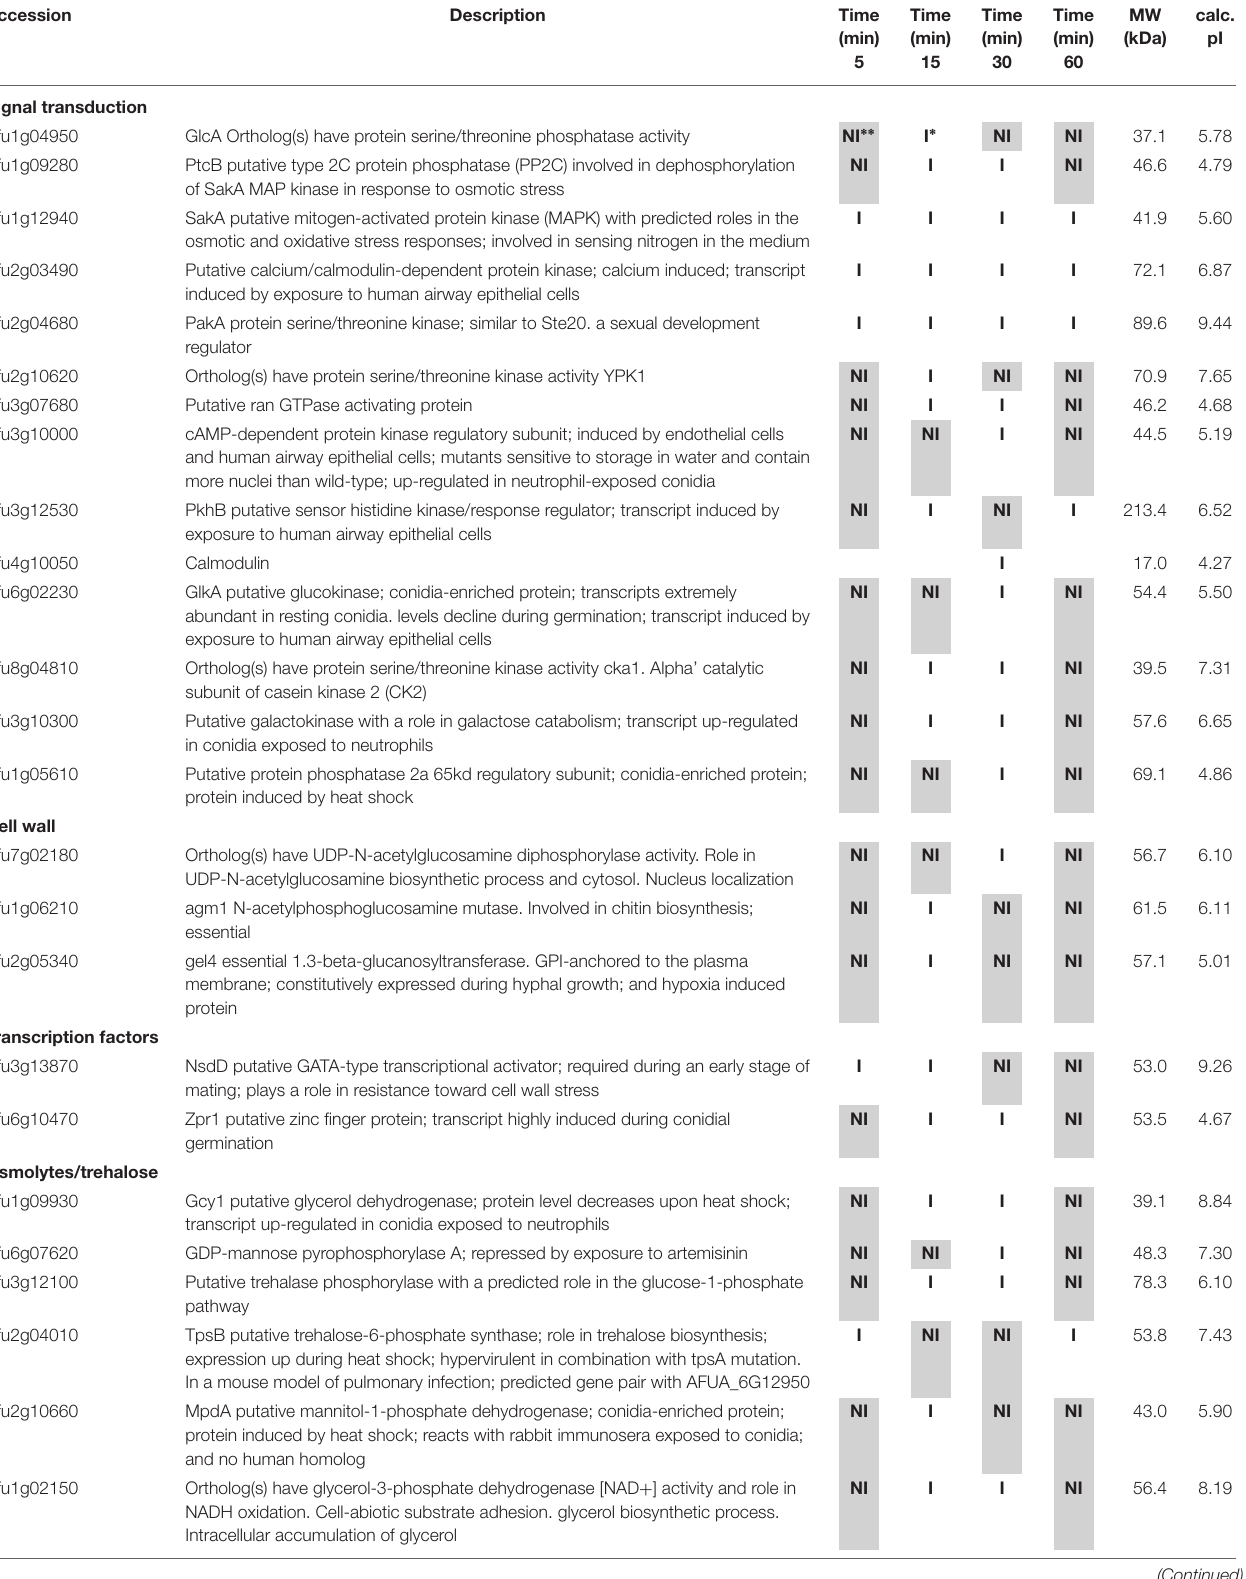
TABLE 3 | Selected proteins interacting with SakA::GFP identified during cell wall stress. Accession Description